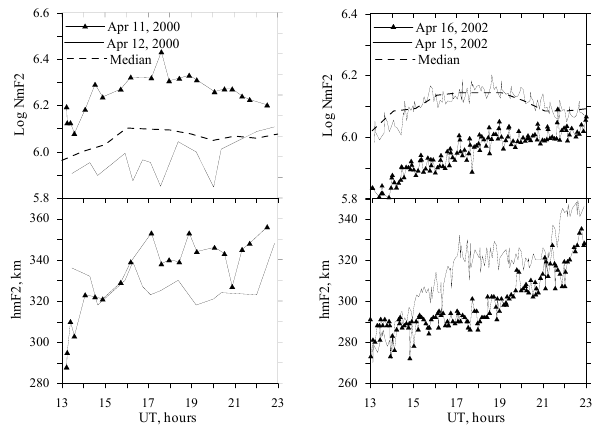
Figure 2. Fig. 2. Positive (11 April 2000) and negative (16 April 2002) Q- disturbances observed at Millstone